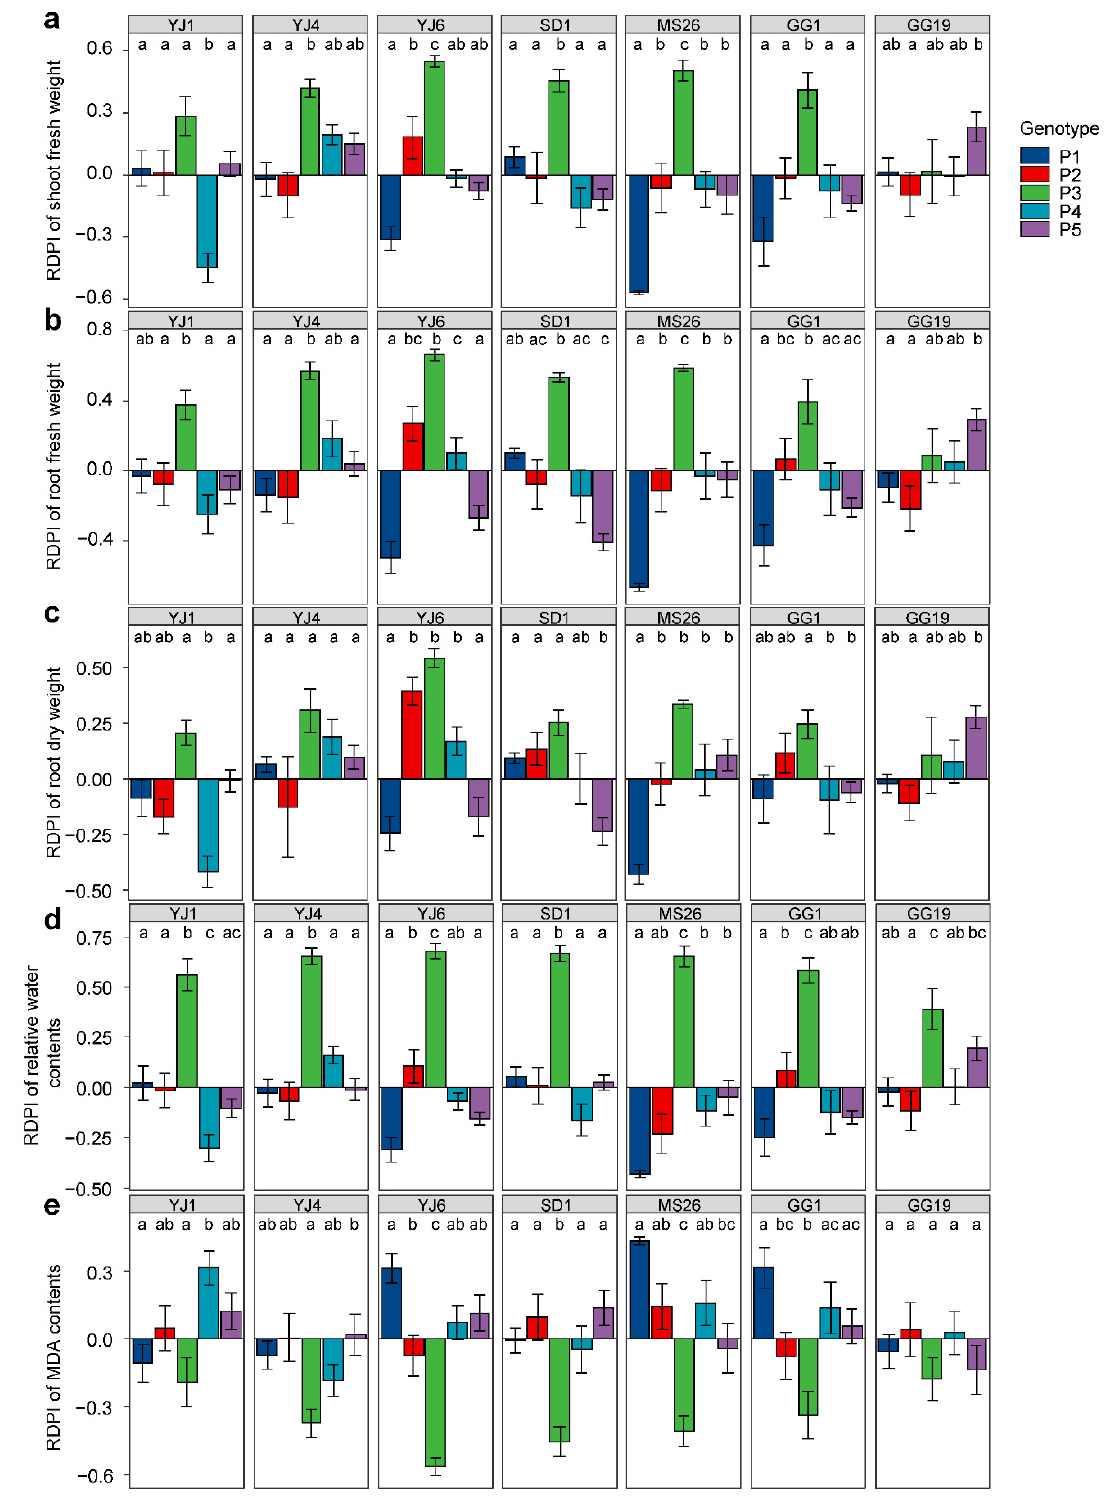
Figure 4. Plastic responses of different Lactuca serriola genotypes to bacterial treatments. Average relative distance plasticity indexes (RDPIs) and standard errors of ( a ) shoot fresh weight, ( b ) root fresh weight, ( c ) root dry weight, ( d ) relative water contents, and ( e ) MDA contents are presented. Letters indicate statistically significant ( p < 0.05) differences among genotypes based on Tukey’s multiple comparison tests. The names of bacterial strains are given in Figure 1.